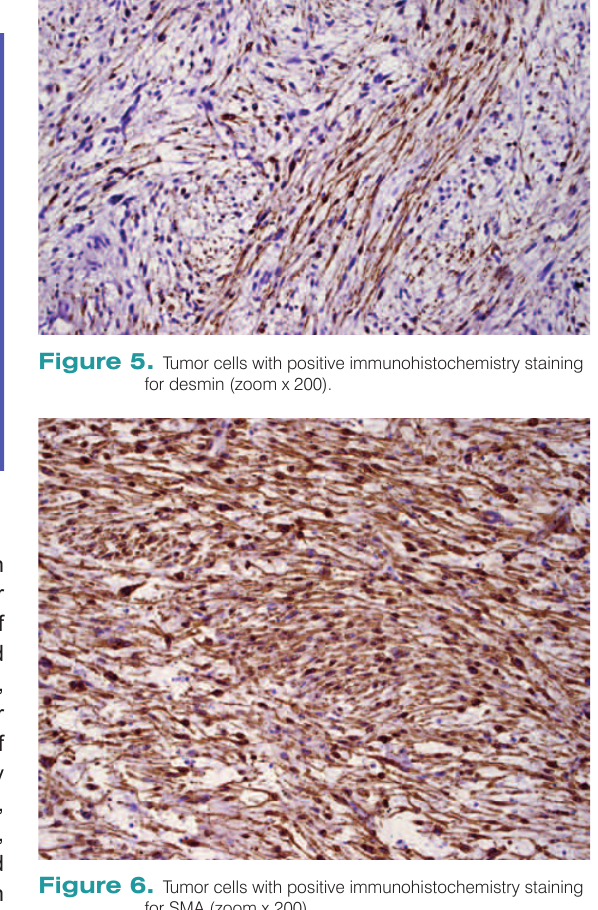
Figure 2. CT scan done during second hospitalization. The image of heart revealed masses in right atrium (marked by ), extended from inferior vena cava. Left atrium is marked by . In addition the free fl uid in both pleural cavities is presented ( ).